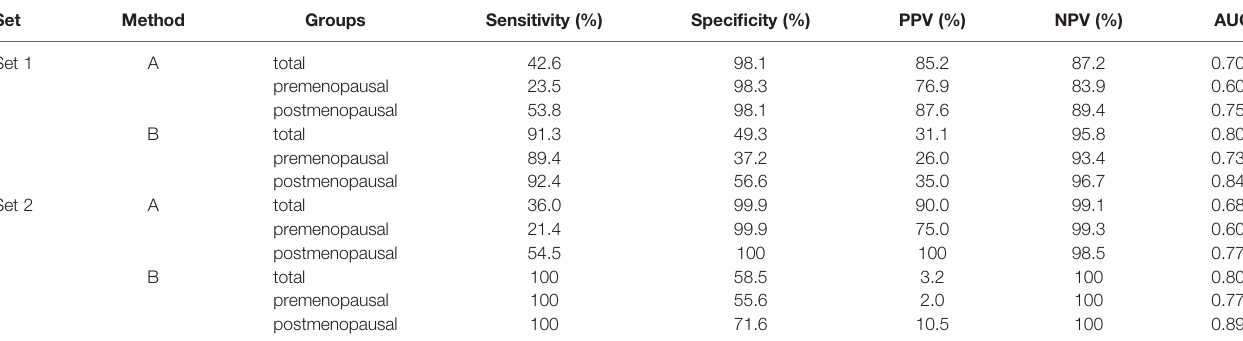
TABLE 6 | The diagnostic value of direct judgment by hysteroscopy and noninvasive predictor. Set Method